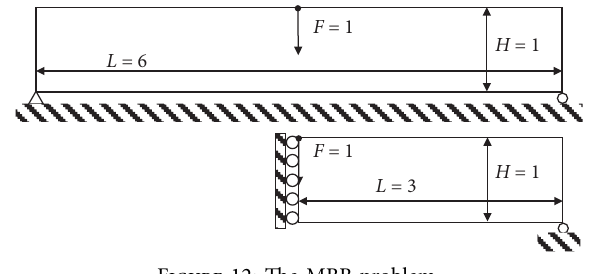
Figure 12: The MBB problem.